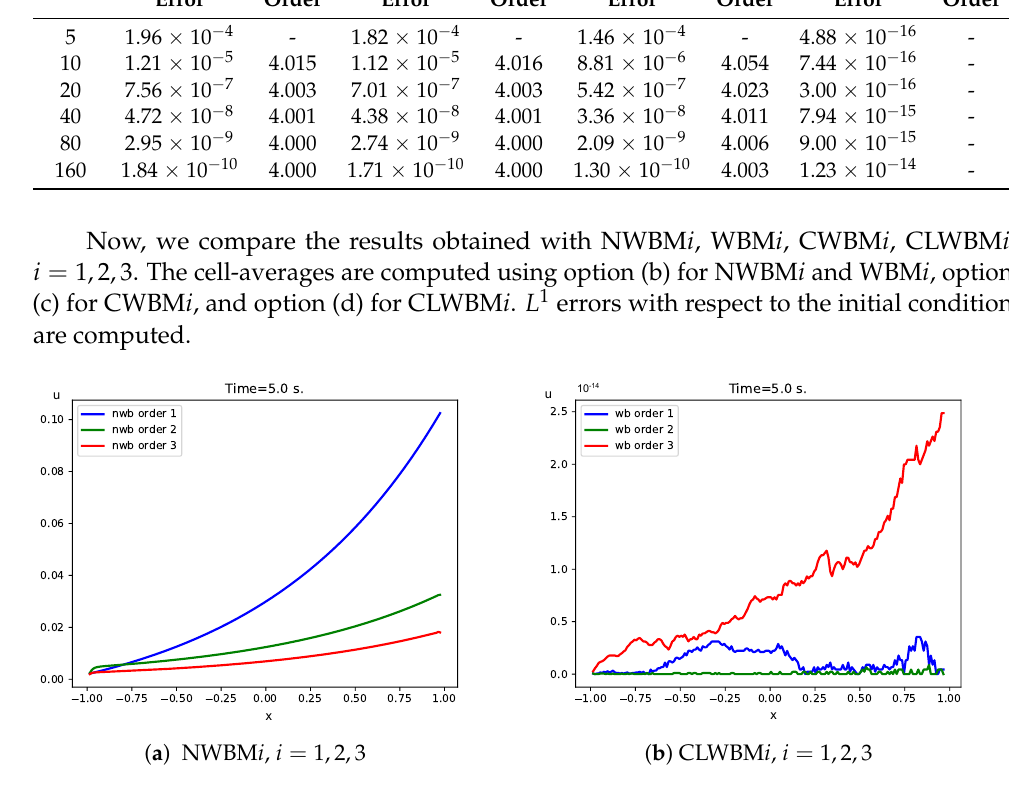
Figure 1. Test 1.1. Differences between the stationary and the numerical solutions at time t = 5 s for a 200 − cell mesh.